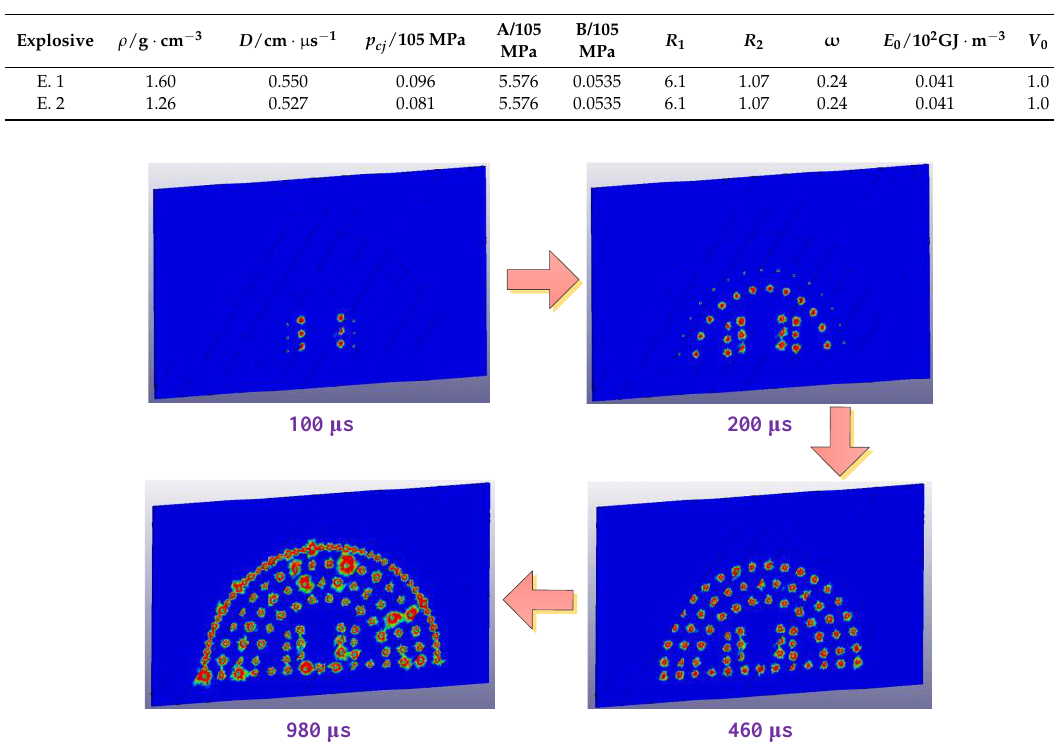
Table 2. Parameters of emulsion explosives